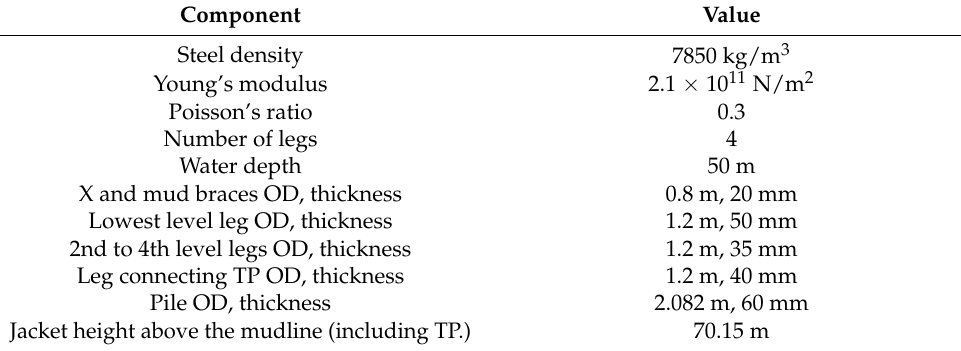
Table 3. OC4 jacket support structure